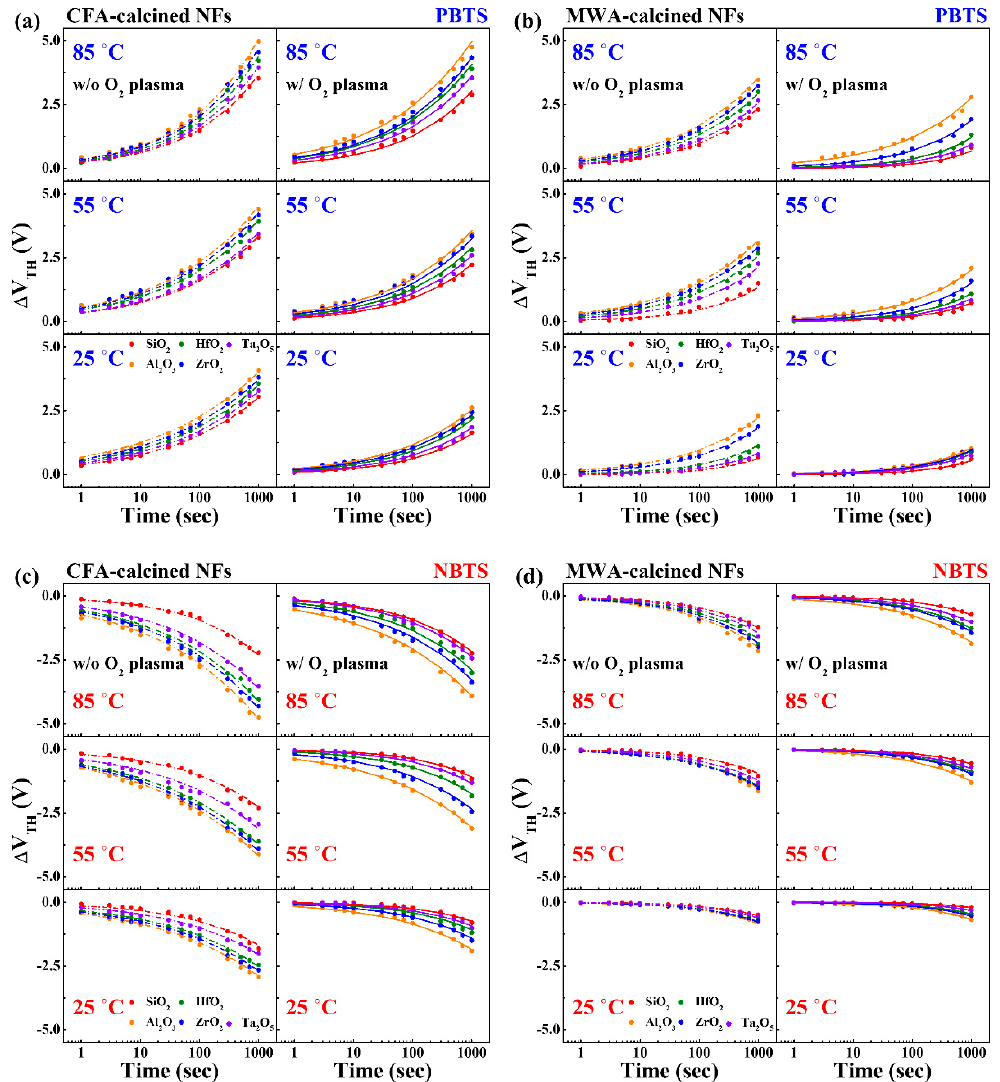
Figure 9. Δ V TH values of IGZO NF FETs as functions of stress time for different high- k dielectrics. ( a ) CFA- and ( b ) MWA-calcined devices during PBTS test and ( c ) CFA- and ( d ) MWA-calcined devices during NBTS test. Dashed and solid lines are fitting curves for data obtained before and after postcalcination oxygen plasma treatment, respectively. Curves were fitted using stretched-exponential equation.